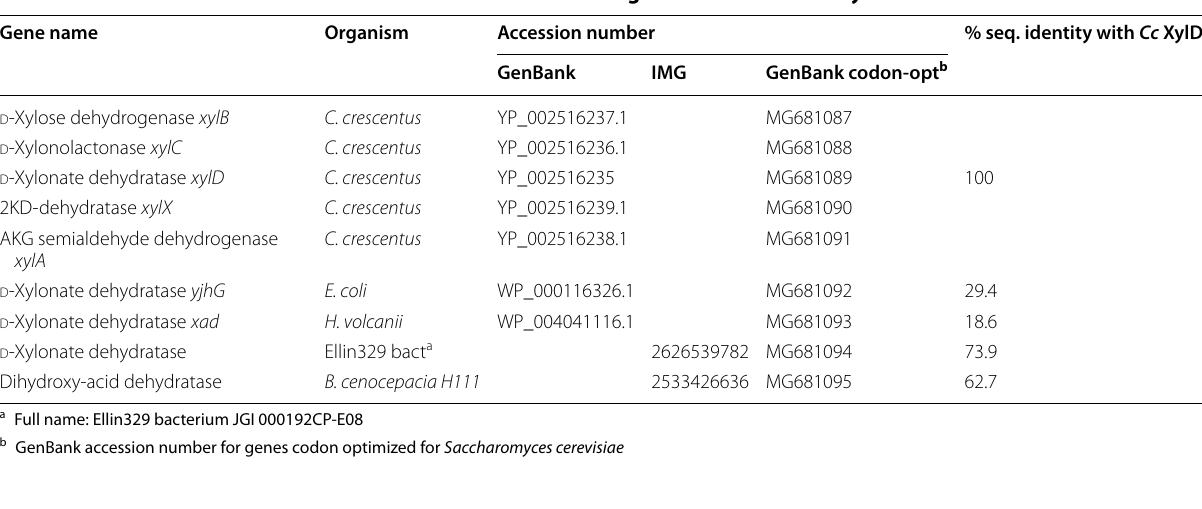
Table 3 Nucleotide accession numbers of the bacterial/archeal genes used in the study